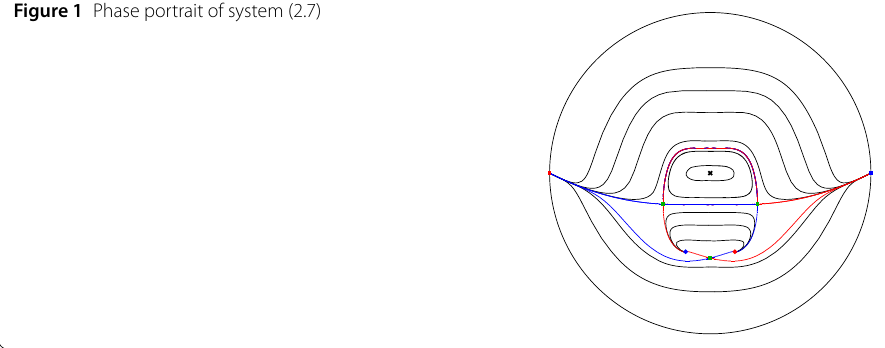
Figure 1 Phase portrait of system